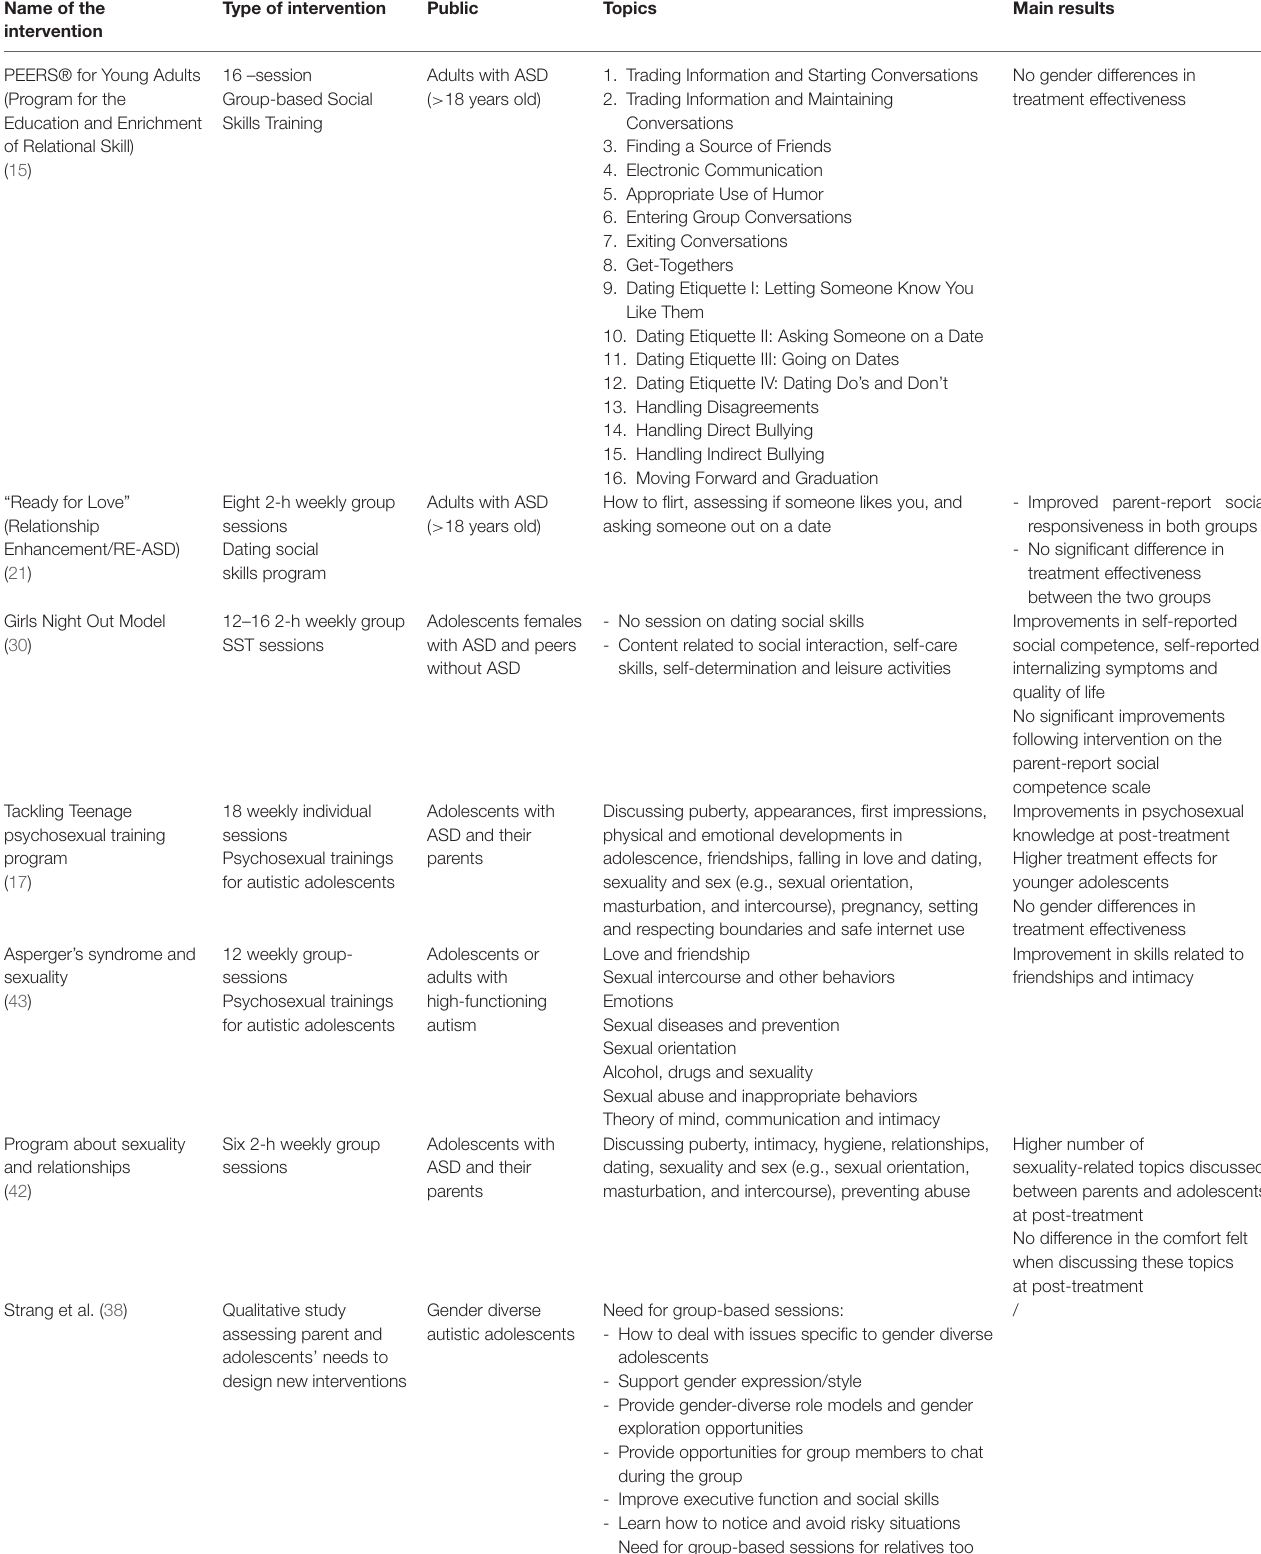
TABLE 3 | Interventions targeting romantic relationships/sexuality. Name of the Type of intervention Public Topics intervention PEERS® for Young Adults (Program for the Education and Enrichment of Relational